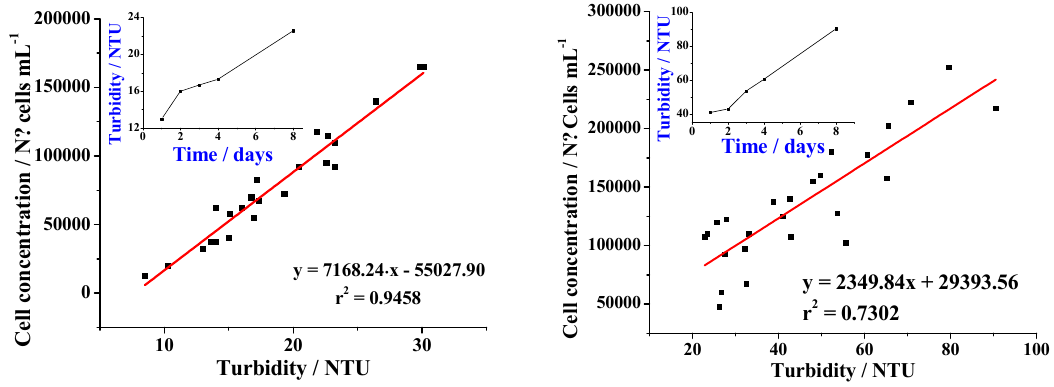
Figure 2. Cell concentration versus suspension turbidity.